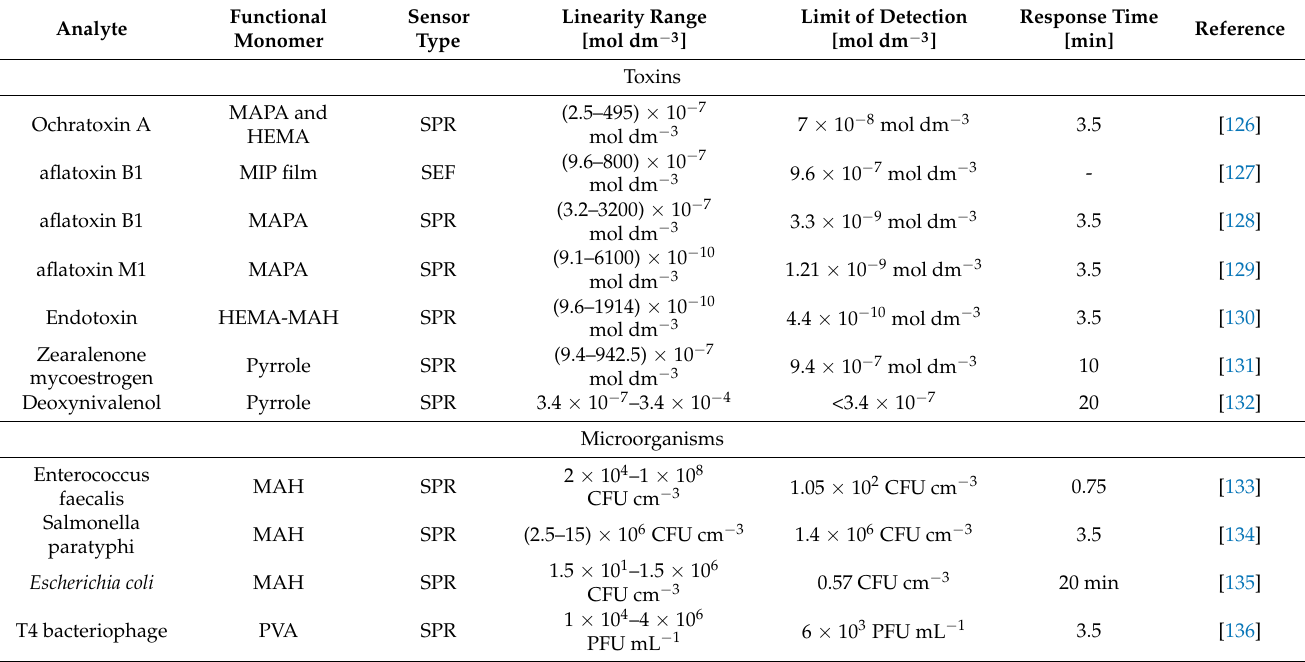
Table 3. MIP plasmonic sensors for the detection of microorganisms and their